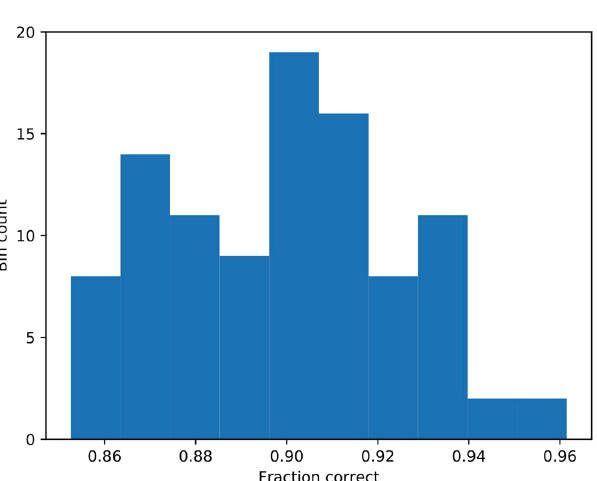
x values that were correctly obtained in the 2D inverse problem is i j , jy values were correctly i ,